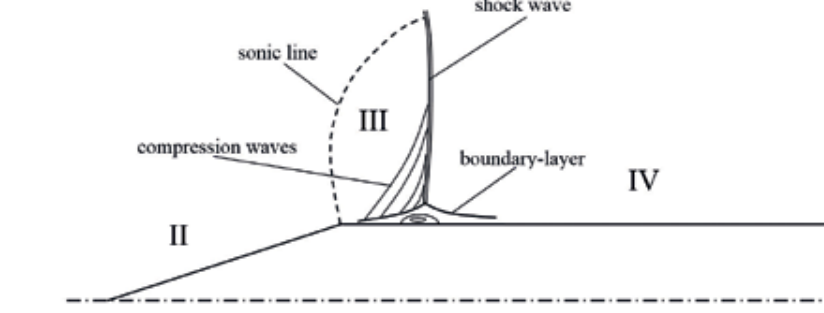
Figure 2. Typical flow pattern scheme of a cone–cylinder model at transonic flow regime. Adapted adapted from Ramaswamy and Rajendra